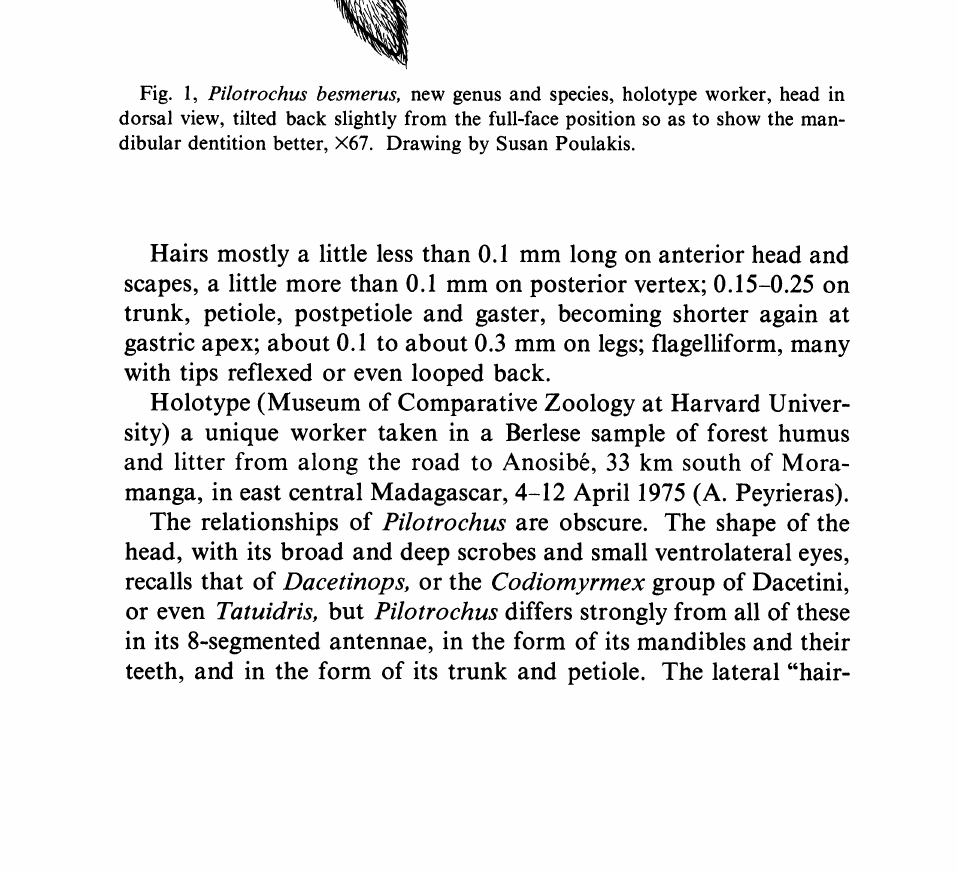
Fig. 1, Pilotrochus besmerus, new genus and species, holotype worker, head in dorsal view, tilted back slightly from the full-face position so as to show the man- dibular dentition better, 67. Drawing by Susan